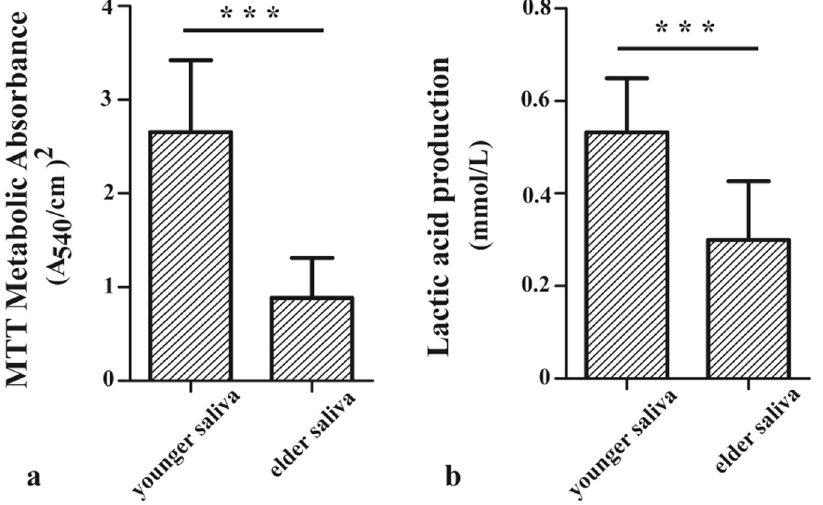
Figure 3. 16S rRNA sequence analysis of two groups of host saliva-transplanted mice; the caries-active group received saliva from the younger sister with caries while the caries-inactive group received saliva from the elder sister without caries. ( a ) Abundance of microorganism in twins and mice saliva. ( b ) Alpha diversity comparison in Shannon, Simpson, Chao 1 and ACE index ( p > 0.05; t-test) of groups of mice. ( c ) Top 15 different genera- level taxa in mice oral microbiota with different host saliva samples. ( * represented for significant difference and ** stand for extremely different between two groups, Wilcoxon rank-sum test). ( d ) PCoA result of comparison between two group of